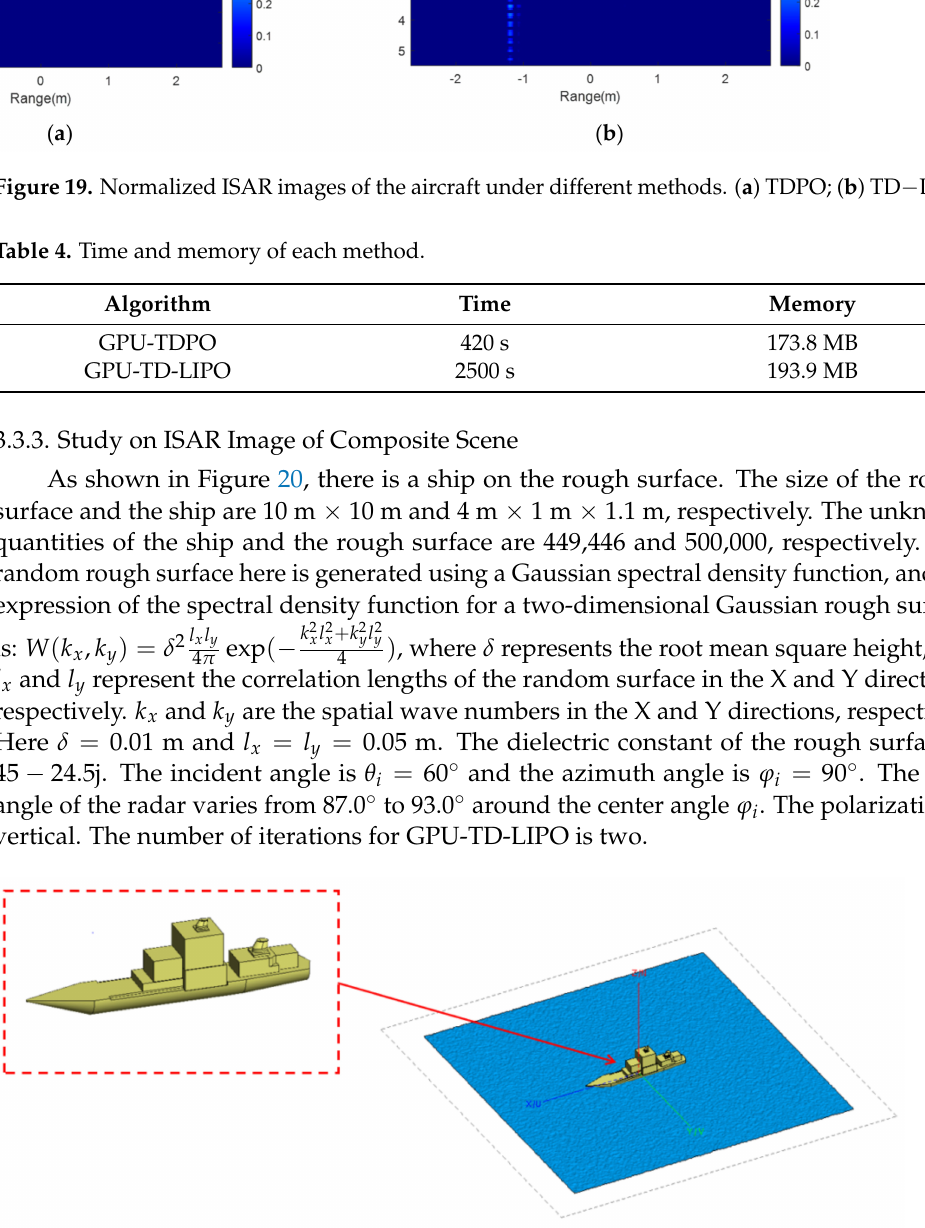
Figure 20. Composite model simulation of a ship at